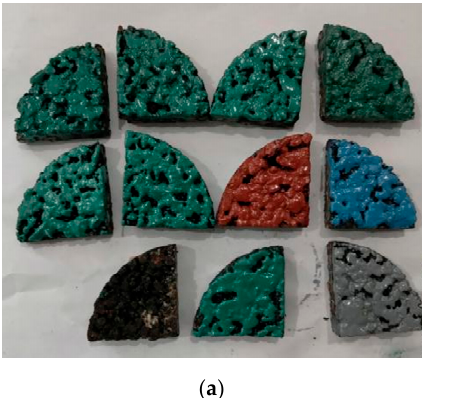
Figure 7. Coating reflectivity test: ( a ) Specimen; ( b ) UV–Vis spectrophotometer